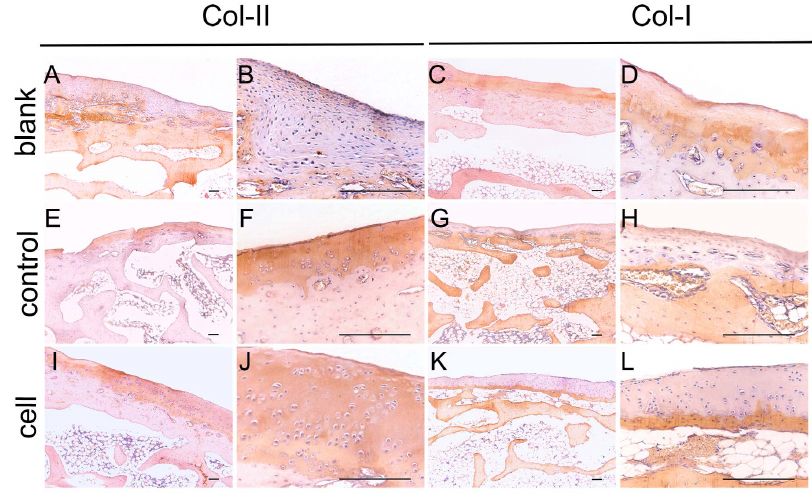
Figure 5. Immunohistochemical assessment of scaffolds and iPSCs in the restoration of cartilage defects at 12 weeks. More collagen II was observed in the cell and control groups, while more collagen I was observed in the blank group. All scale bars represent 200 m m.